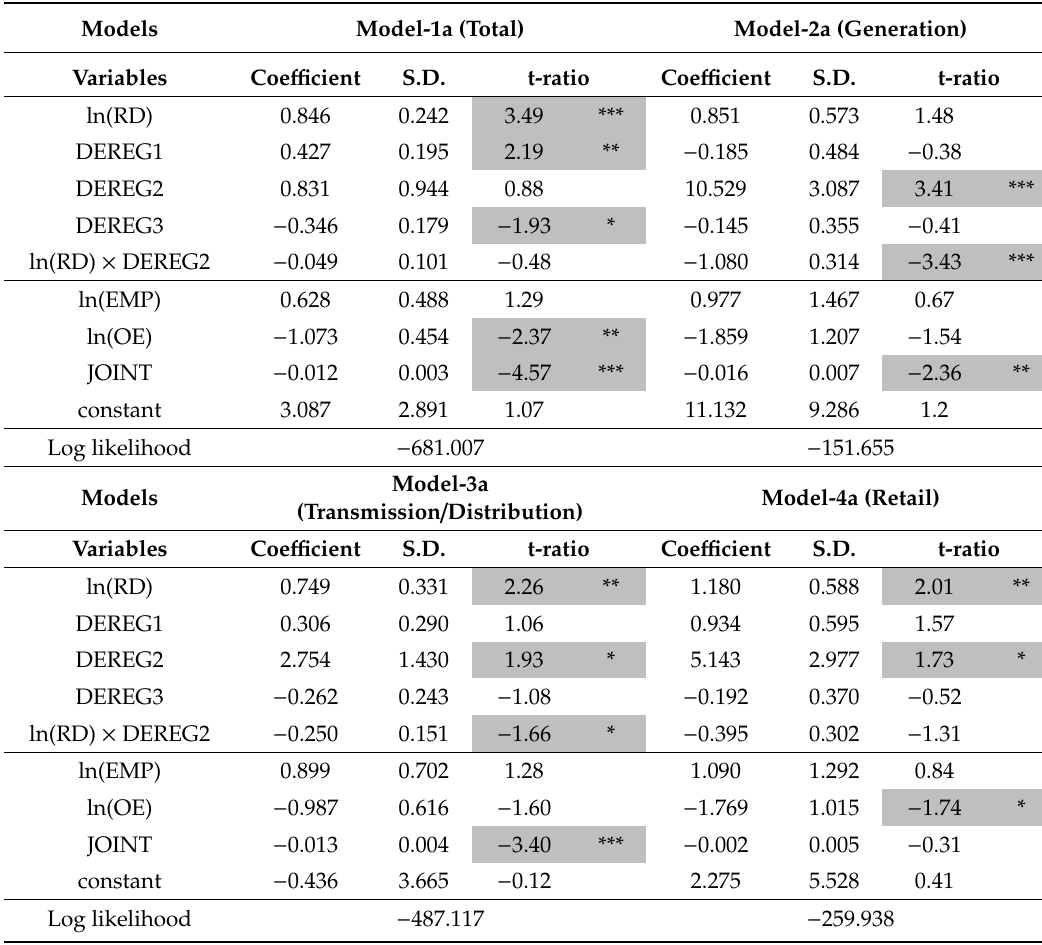
Table A1. Estimation results (with cross